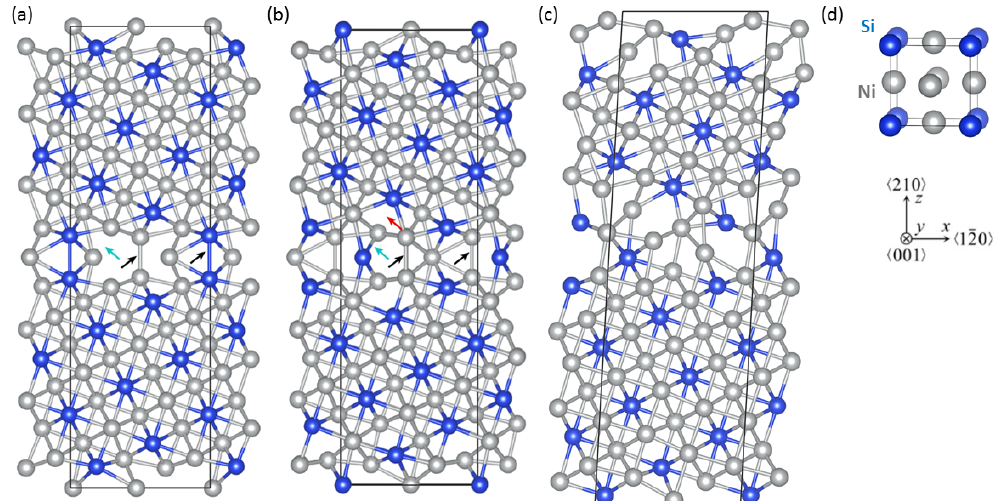
Figure 1. Visualization of computational supercells used in our calculations of interface states related to the Σ 5(210) GBs in Ni 3 Si with different stoichiometries, ( a ) Σ 5(210) Ni,Ni with only Ni atoms at the GB plane, ( b ) Σ 5(210) Si,Ni with both Si and Ni atoms at the GB plane (mechanically unstable configuration characterized by a rectangular-parallelepiped supercell), ( c ) mechanically stable shear-deformed state of Σ 5(210) Si,Ni and ( d ) cubic L1 2 unit cell of bulk Ni 3 Si together with crystallographic directions of GB supercell vectors (before the shear deformation). The Ni atoms are visualized as the blue spheres while the Si atoms as the gray ones. Arrows indicate specific inter-atomic bonds discussed in the text (see below). Please note that some atoms are shown together with their periodic